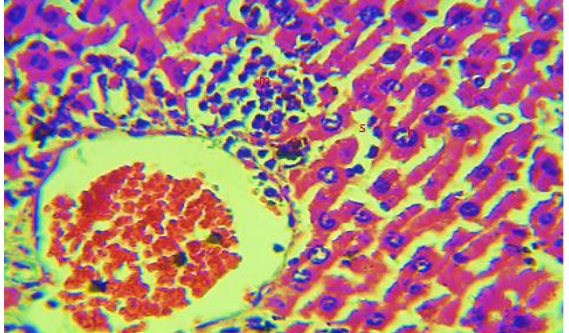
Figure, 2: Photomicrograph of a section of the liver of rats T1 group, mononuclear cell aggregation around and inside blood vessels .m=mononuclear cell, k= kupffer cell, s= sinusoid.X40, E and H Stain.